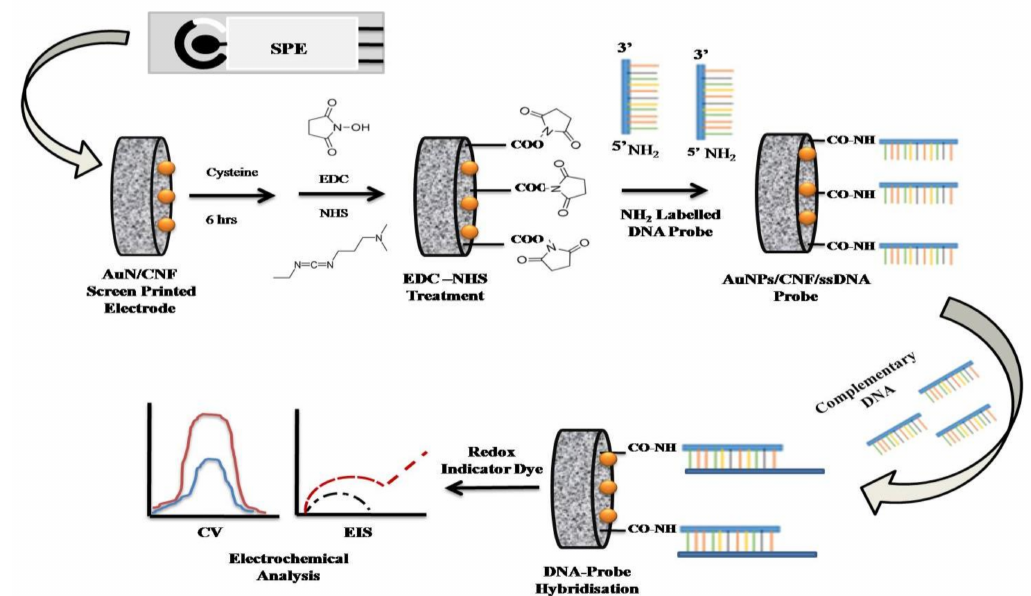
Scheme 1. Illustration of steps involved in the construction of the DNA sensor. AuN: Gold Nanoparticles, CNF: Carbon Nanofiber, SPE: Screen-Printed Electrode, MPA: 3-Mercaptopropionic acid, CV: Cyclic Voltammetry, EIS: Electrochemical Impedance Spectroscopy, EDC: 1-Ethyl-3-(3-dimethyl aminopropyl) carbodiimide, and NHS: